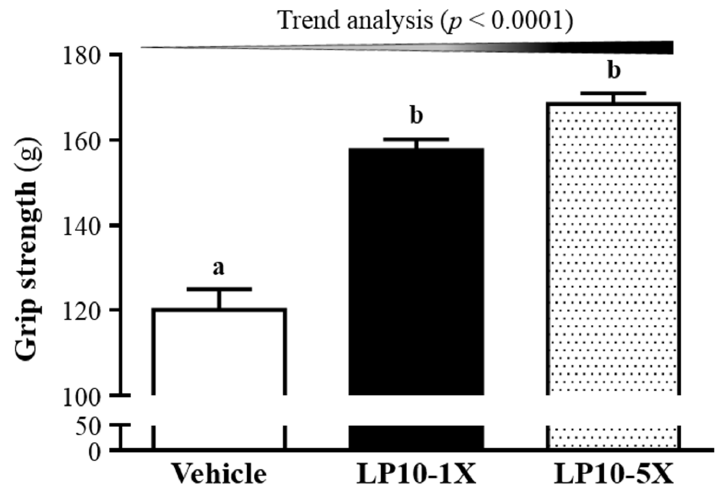
Figure 1. Effects of LP10 ( Lactobacillus plantarum TWK10) supplementation for six weeks on forelimb grip strength. Mice were pretreated with vehicle, LP10-1X, or LP10-5X for six weeks, and then forelimb grip strength was tested. Data are mean ± SEM, 8 mice/group, by one ‐ way ANOVA. Different letters (a, b) indicate a significant difference at p < 0.05.